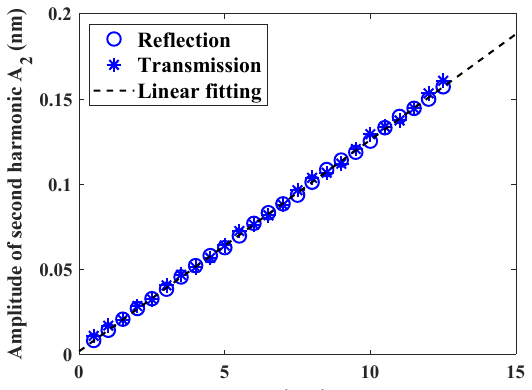
Figure 7. Amplitude variation of the second harmonic for reflected and transmitted waves with the propagation distance.